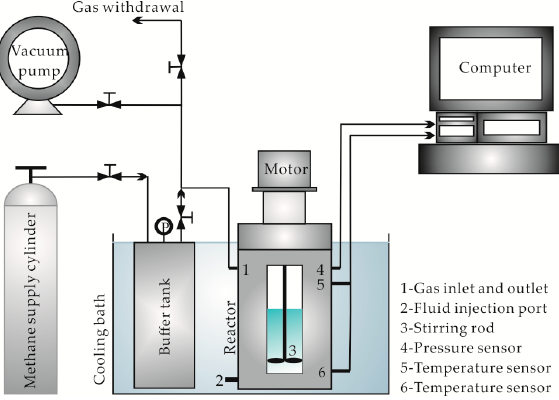
Figure 1. Schematic of the experimental setup.